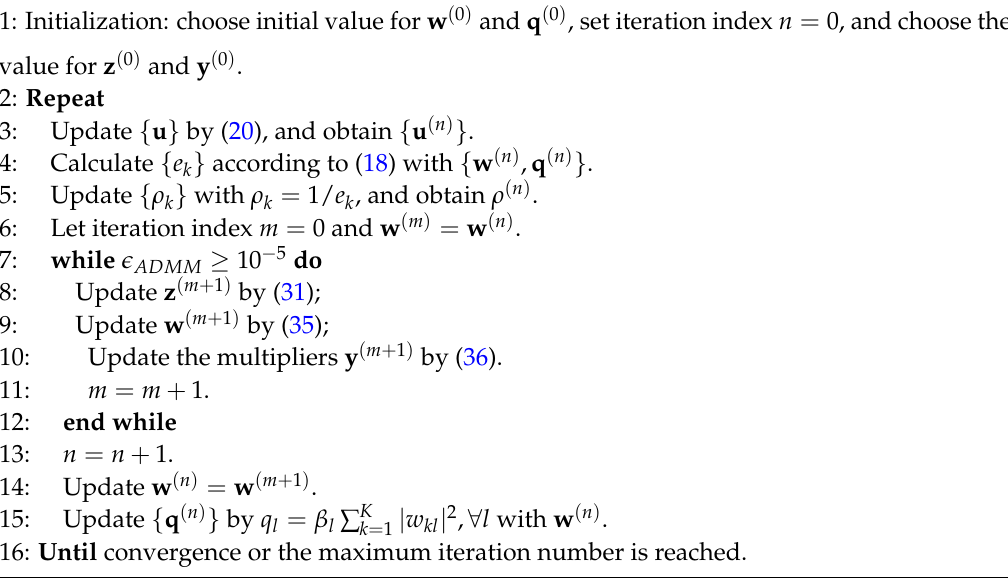
Algorithm 3 Decentralized Algorithm for Subproblem P 3